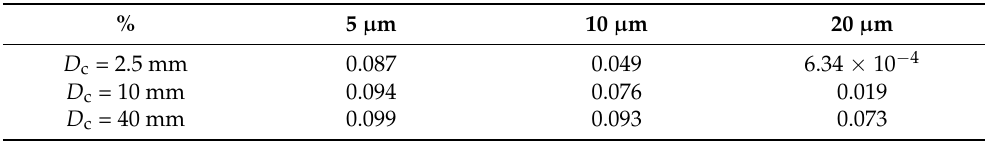
Table 5. Average particle concentration at overflow